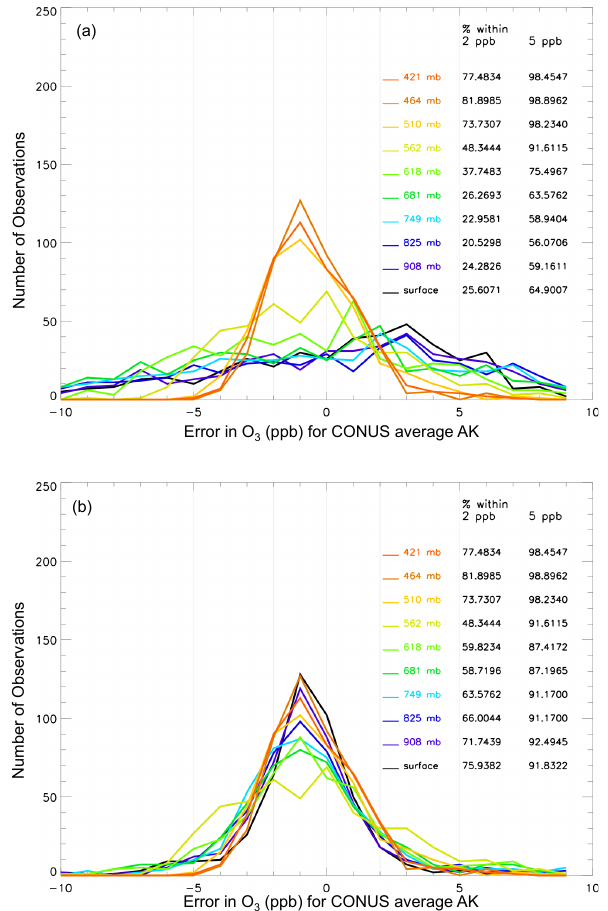
Fig. 17. Same as Fig. 16, but with error expressed in ppb and only showing pressures higher than 400hPa. (a) Performance of CONUS average AK compared to true AKs for TES-OMI test cases. (b) Per- formance of predicted AKs compared to true AKs for TES-OMI test cases. For pressures below 600hPa, the CONUS average AK is ap- plied. Histograms of O 3 error in ppb are plotted for each pressure (indicated by colors on the right). Listed on the far right are the per- centages of test cases that fall within 2 and 5ppb O 3 error for each